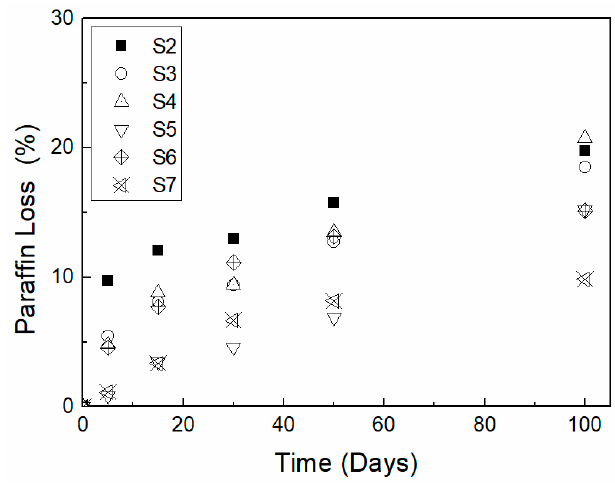
Figure 2. The leakage of PCMs during days of artificial aging.